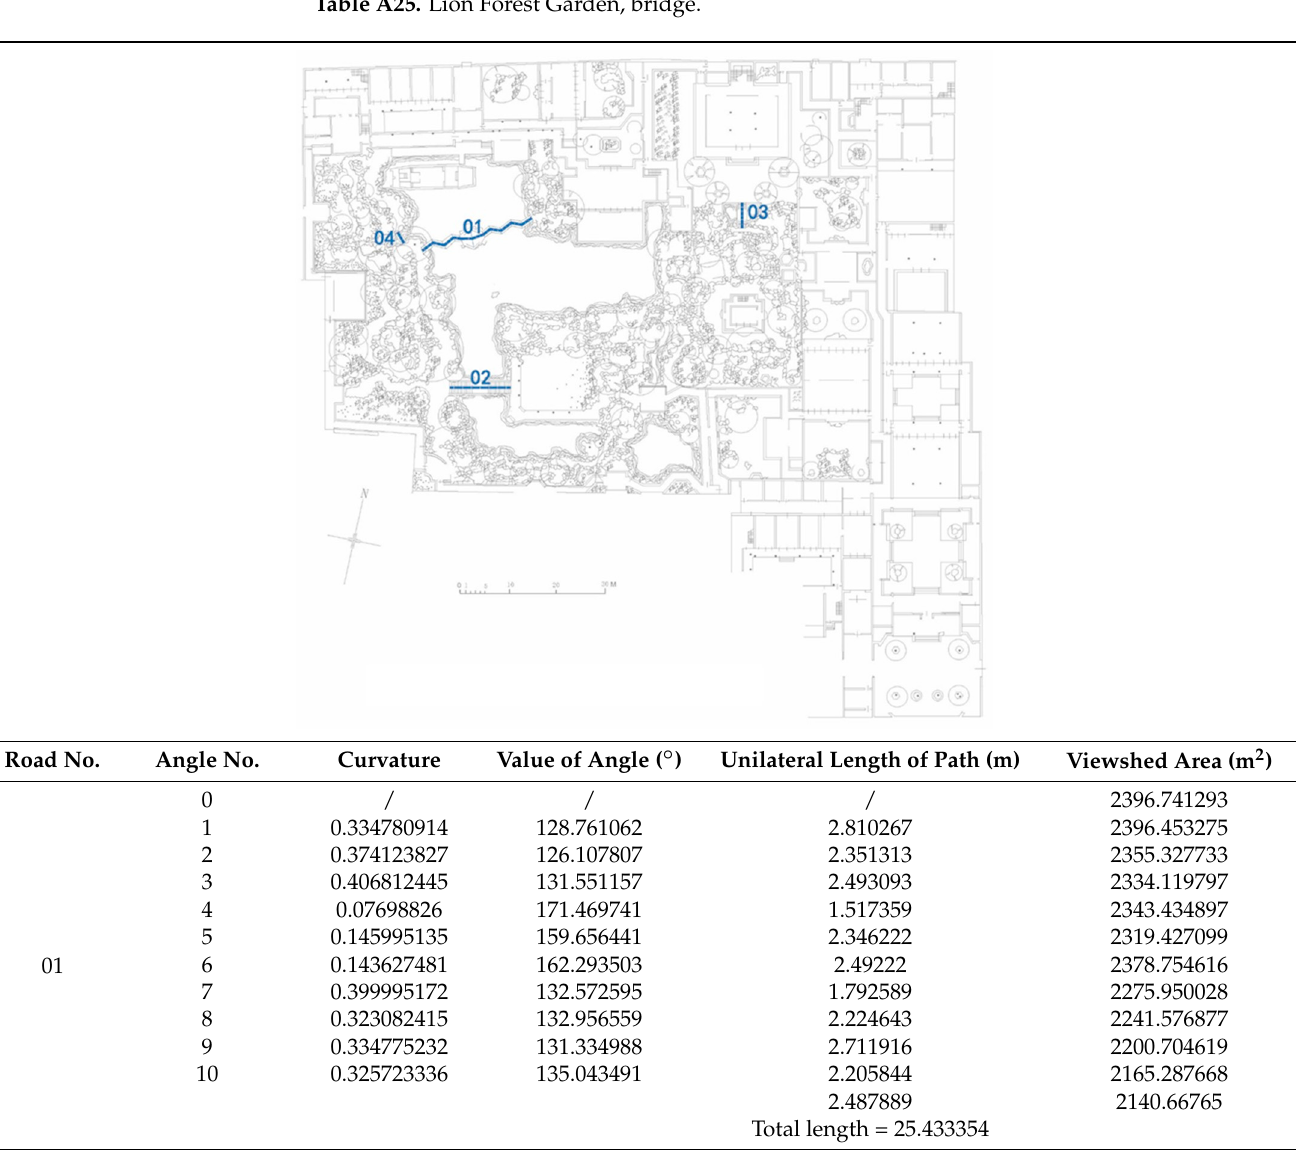
Table A25. Lion Forest Garden, bridge.